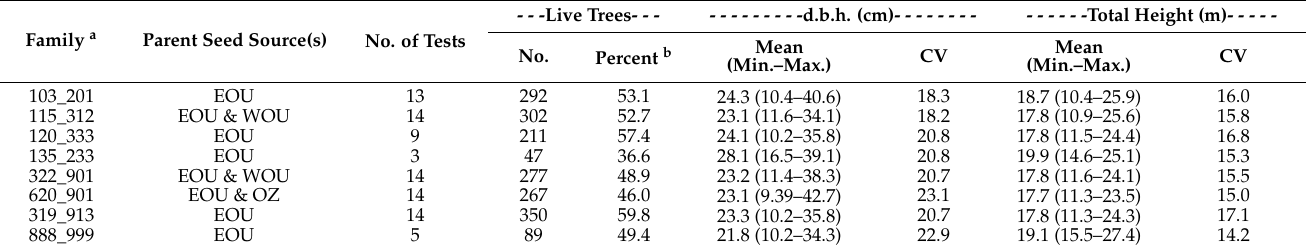
Table 3. Statistics on the shortleaf pine families remeasured on three or more of the progeny tests visited in 2018–2019. Family a Parent Seed Source(s)